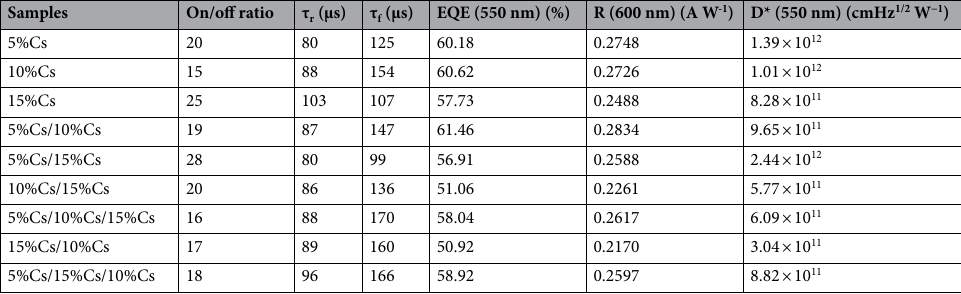
Table 3. Averaged values of photodetector parameters for single, double, and triple-layer perovskite devices, over 8 devices for on/off ratios, τ r , and τ f, and over 4 devices for EQE, R, and D*.